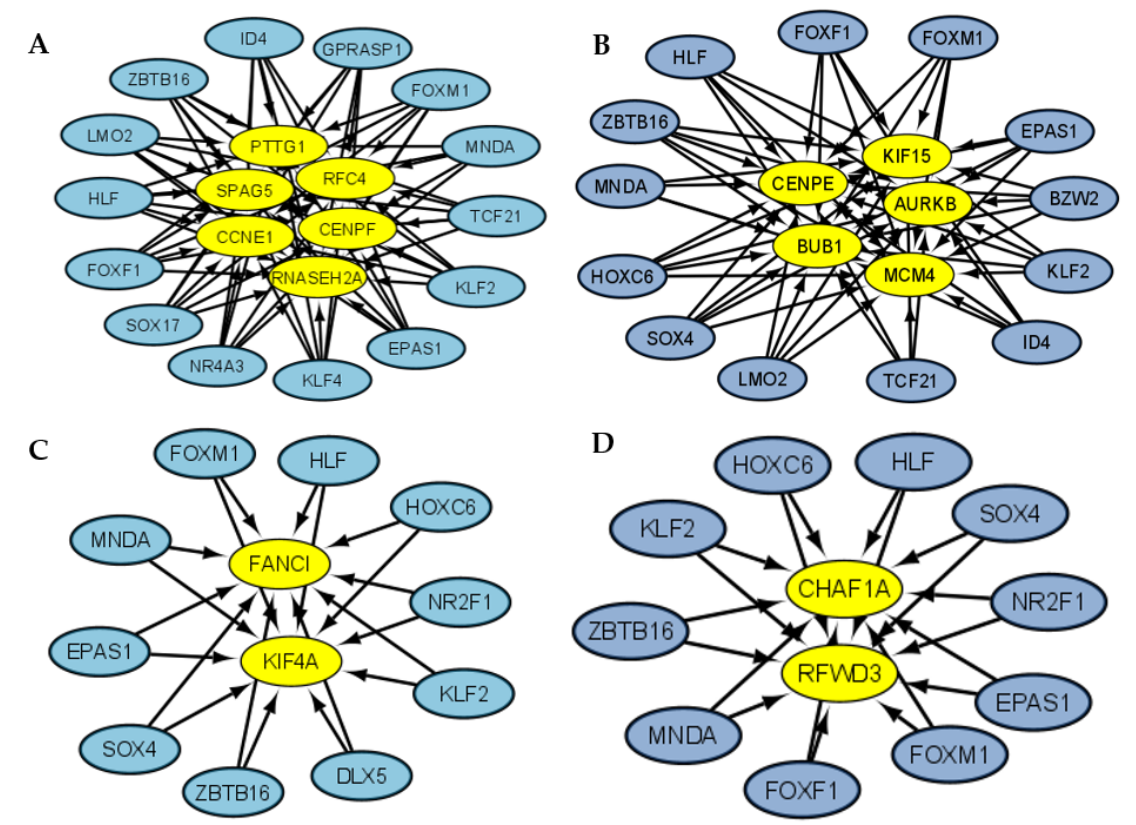
Figure 7. Largest blocks from fibration symmetries analysis related to the control of gene expression of ( A ) NSCLC and PAH deregulated genes, ( B ) NSCLC deregulated genes, ( C ) SCLC and PAH de- regulated genes, and ( D ) SCLC deregulated genes.